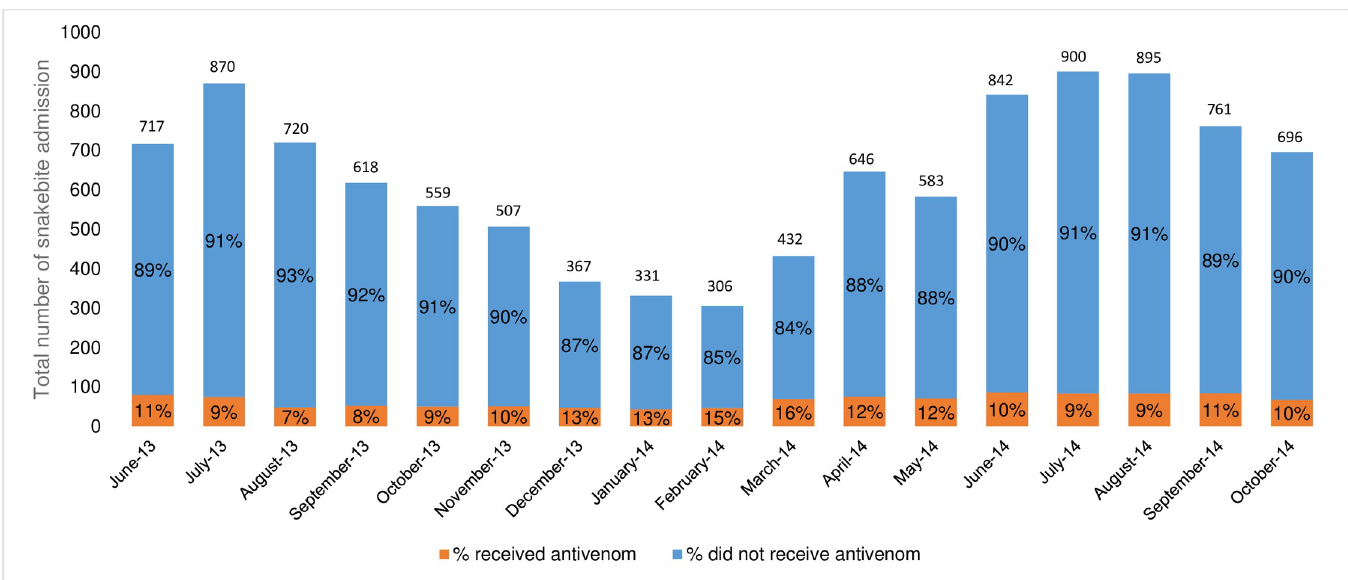
Fig 2. Number of hospitalised snakebite patients in the three regions studied and the percentage of patients that did, and did not receive antivenom treatment.